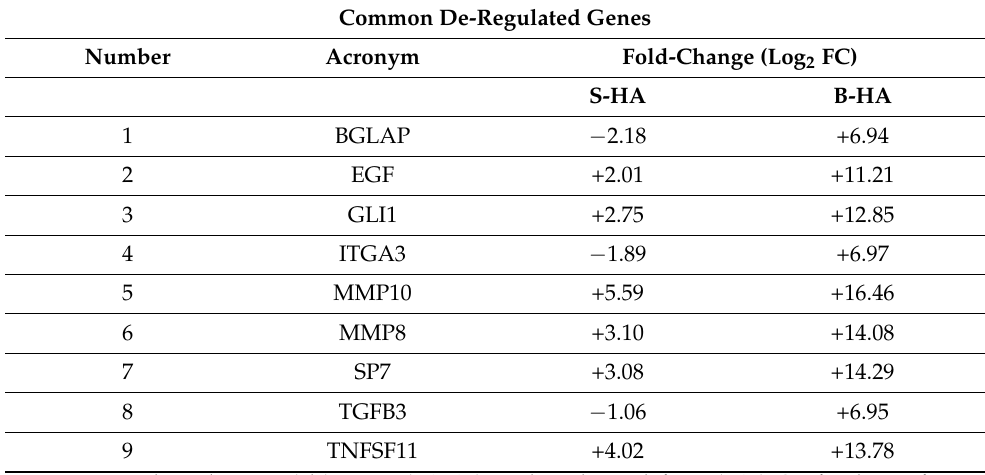
Table 1. Genes found to be de-regulated in human adipose stem cells (hASCs) grown on biomorphic HA (B-HA) and sintered HA (S-HA) scaffolds at day 14. Common De-Regulated